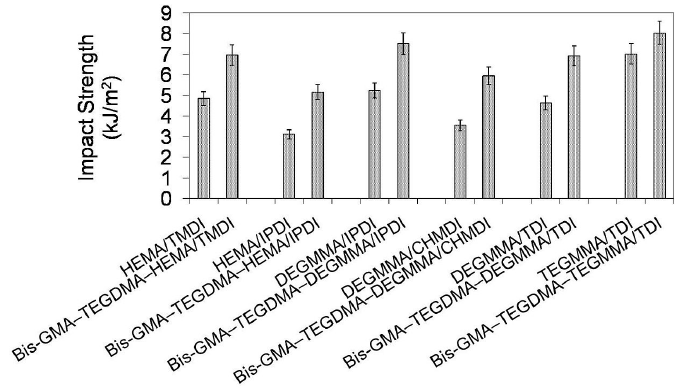
Figure 13. The impact strength of homopolymers and copolymers composed of UDMA, Bis-GMA, and